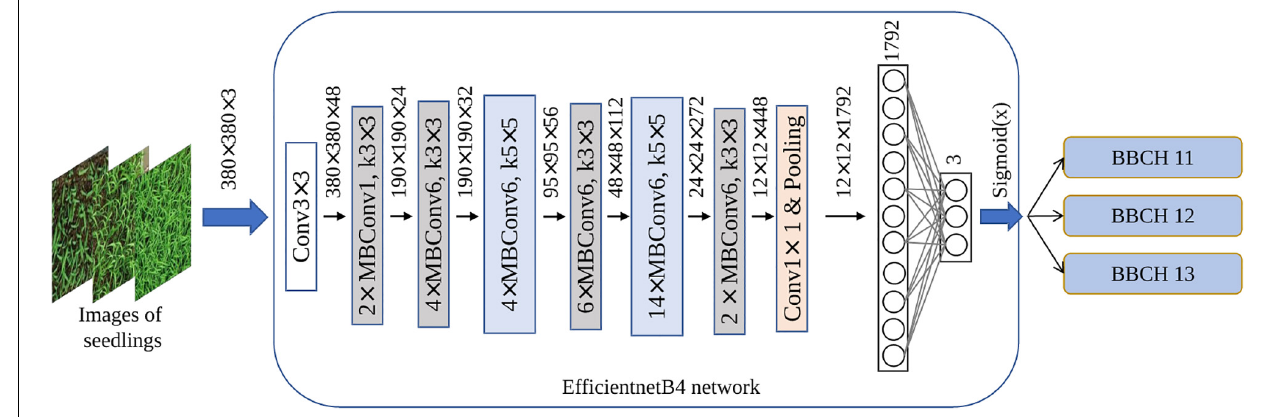
FIGURE 4 | Diagram of the EfficientnetB4 used to detect rice seedling growth stages.